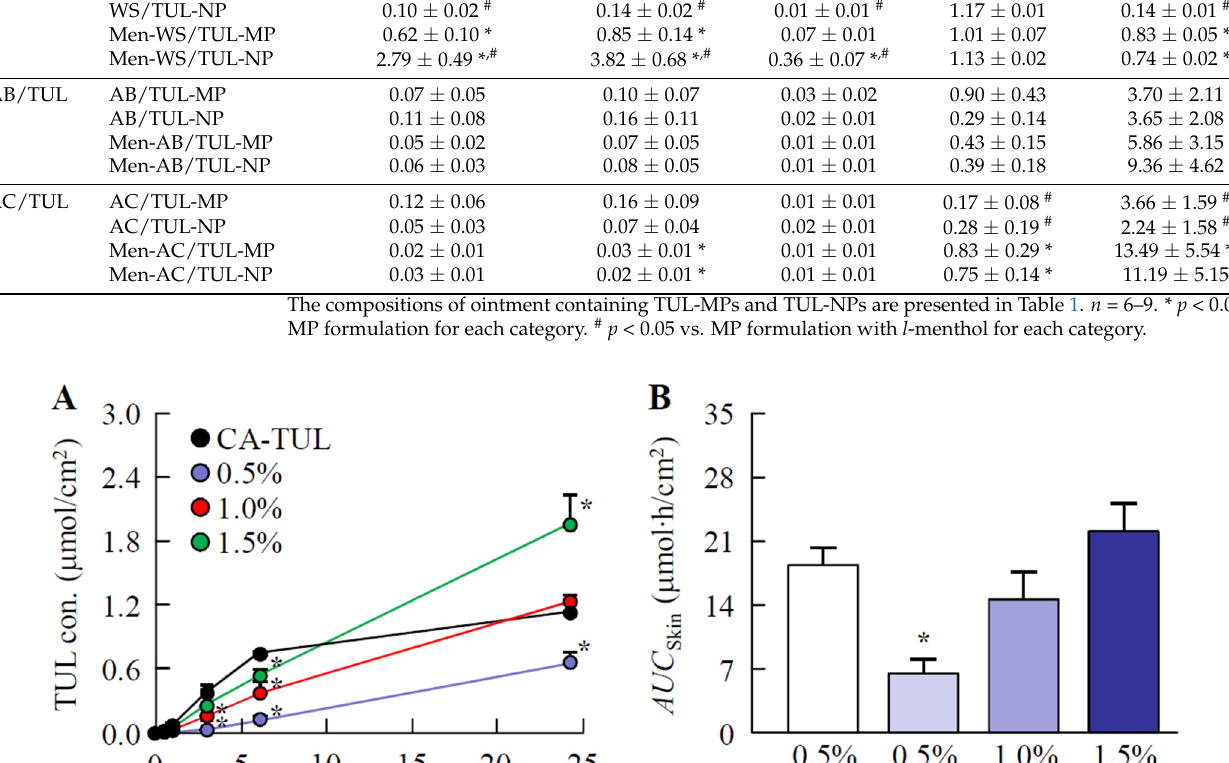
Table 3. Pharmacokinetic analysis of TUL transdermal formulations in the in vitro penetration of rat skin.